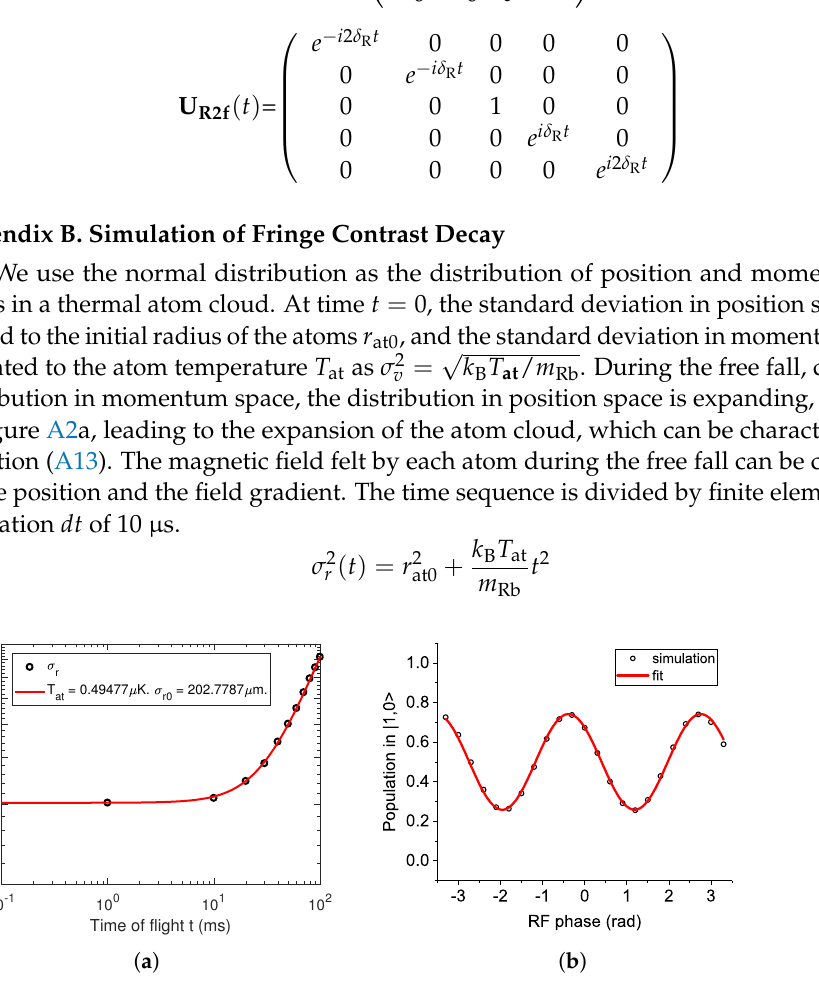
Figure A2. ( a ) Simulation of expansion of atom cloud during free fall, the red fitted line shows the atom temperature of 500 nK and initial cloud radius of 200 µ m. ( b ) Simulation of decay of fringe contrast for a thermal atom cloud employed by Ramsey sequence of two π /2